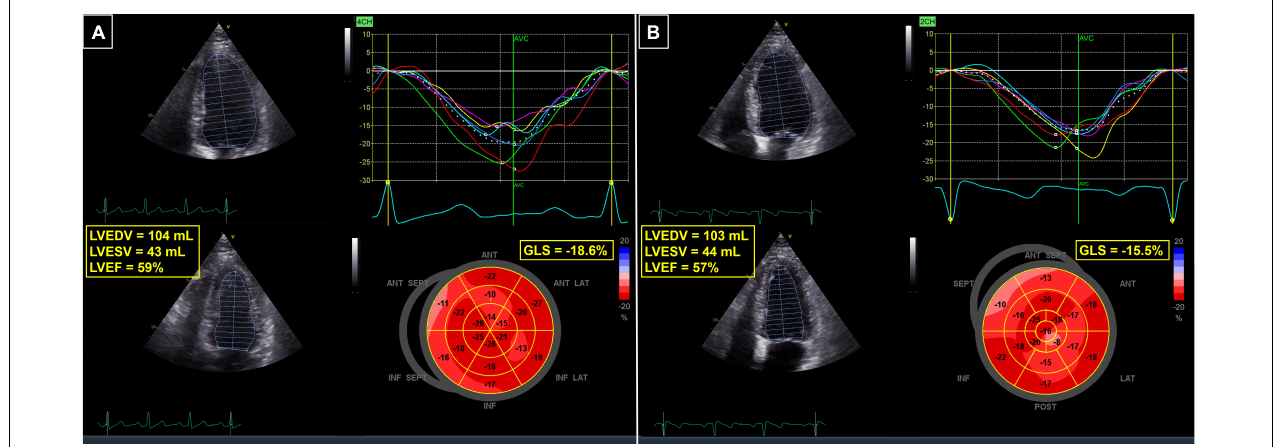
FIGURE 3 | 62-year-old patient with breast cancer undergoing chemotherapy with anthracyclines and radiotherapy. (A) Baseline echocardiogram, showing normal LVEF and GLS. (B) Follow-up echocardiogram 3 months after completion of therapy—the LVEF was still normal, but a 17% relative reduction in GLS revealed cardiotoxicity. GLS, global longitudinal strain; LVEDV, left ventricular end-diastolic volume; LVEF, left ventricular ejection fraction; LVESV, left ventricular end-systolic